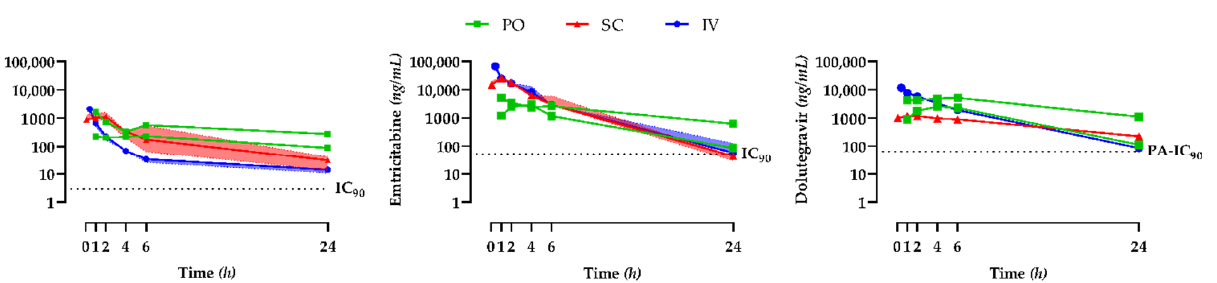
Figure 1. Tenofovir, emtricitabine, and dolutegravir total plasma pharmacokinetic profiles after a single dose. For the subcutaneous (SC, red) and intravenous (IV, blue) routes, the continuous lines and coloured areas represent the median and interquartile range, respectively. Individual data are represented for the oral (PO, green) route. Abbreviations: IC 90 : wild-type HIV-1 90% inhibitory concentration, PA-IC 90 : protein-adjusted wild-type HIV-1 90% inhibitory concentration.